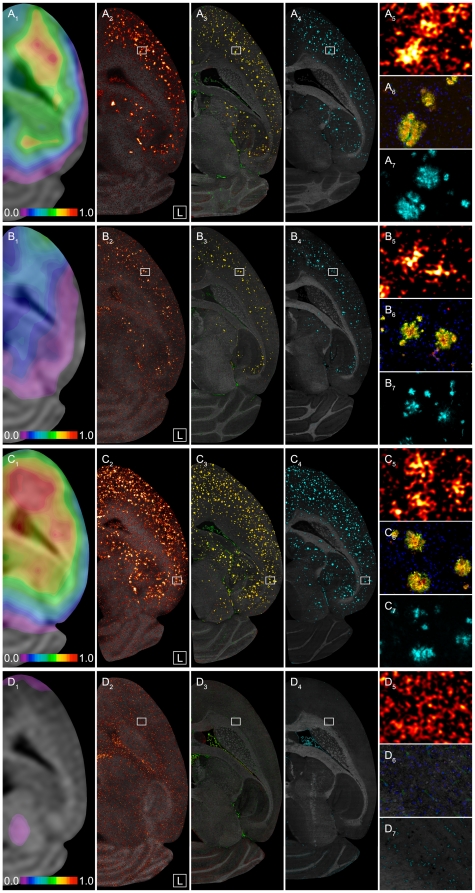
Mouse Aβ plaque pathology in vivo and ex vivo.PET binding potential maps for [11C]PiB and corresponding autoradiography and fluorescence microscopy images of neighboring horizontal brain sections showing data from the same animals presented in Figure 1. Left brain halves are shown. Frontal cortex is at top and cerebellum at bottom of each panel. (A) 23 month old female hemizygous APP/PS1 mouse, (B) 9 month old female homozygous APP/PS1 mouse, (C) 21 month old female homozygous APP/PS1 mouse, (D) 23 month old female C57BL/6J control mouse. Column (1): Binding potential maps for [11C]PiB (BPND, MRTM2) matched to MRI. Shown is the same horizontal level as in Figure 1 and S1. Color table is UCLA (Pmod). Width of color scale represents 3 mm in reality. Column (2): Digital [3H]PiB ex vivo autoradiograph with optical image (gray) of a brain section of the same animal, killed 1 hour p.i.. Color table is Red Hot (ImageJ). Column (3): Double immunofluorescence microscopy for Aβ40 (green) and Aβ42 (red). Anatomical reference (gray) is provided by control channel (Cy3). Column (4): Thioflavin S fluorescence (FITC excitation, cyan). Anatomical reference (gray) is provided by DAPI fluorescence. Right column: Identical Aβ plaque constellations of adjacent sections (as marked by white rectangle in columns (1) to (3). Top panel (5): magnification of digital autoradiograph as seen in column (2). Middle panel (6): corresponding magnified view of Aβ40/Aβ42 stain as seen in column (3). Bottom panel (7): corresponding magnified view of Thioflavin S stain as seen in column (4). Columns (2) to (4) show directly neighboring 10 µm thick sections of the left brain half from bottom to top of skull at about 1.9 mm below Bregma. Width of zoom panels in rightmost column represents 350 µm in reality. Complete orthogonal views for binding potential maps are shown in Figure S1.